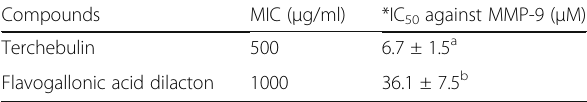
Table 4 Minimum inhibitory concentration (MIC) and matrix metalloproteinases − 9 (MMP-9) inhibitory activities of isolated compounds from Combretum hartmannianium bark Compounds MIC ( μ g/ml) Flavogallonic acid